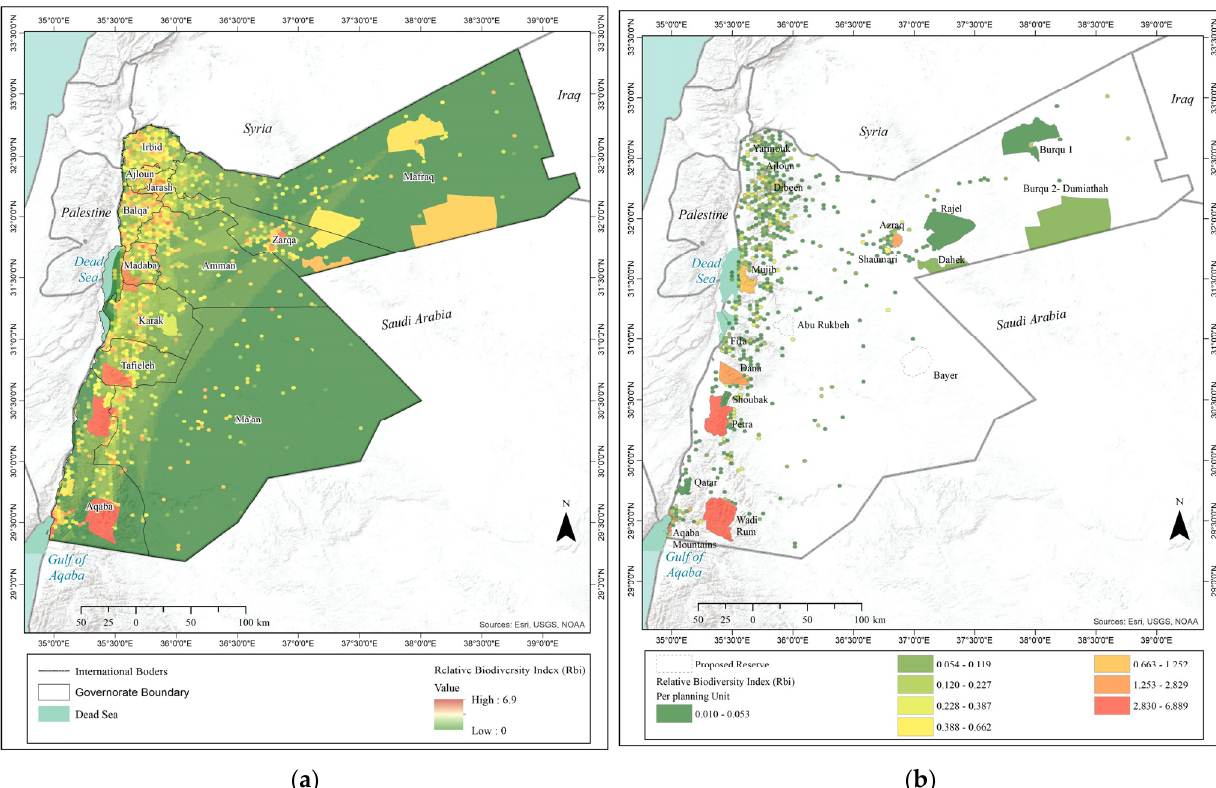
Figure 3. ( a ) Relative biodiversity index RBI; ( b ) planning units with above average RBI values.